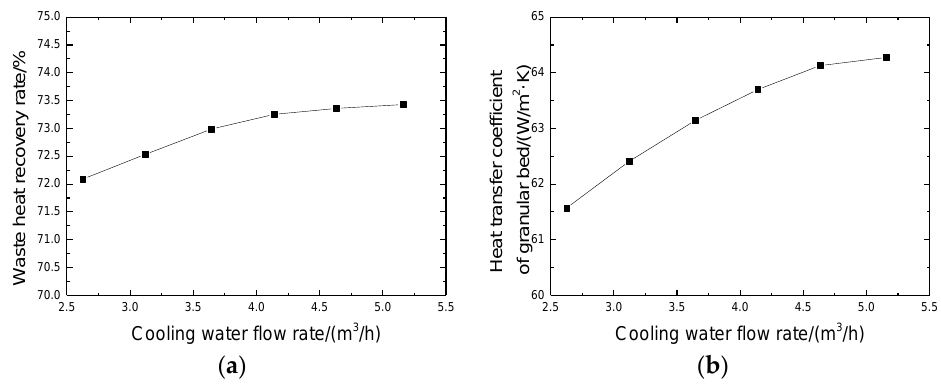
Figure 5. Influence curves of cooling water flow on waste heat recovery. ( a ) Influence on the recovery rate of waste heat. ( b ) Influence on the heat transfer coefficient.